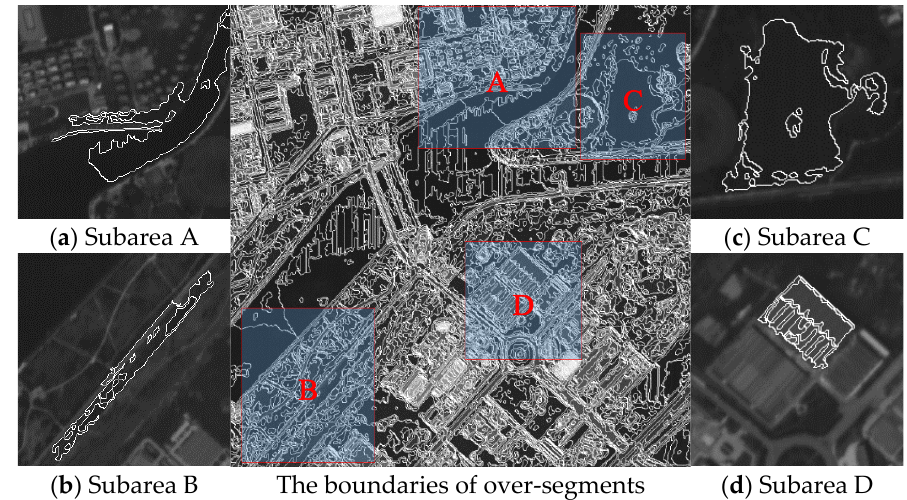
Figure 8. The boundaries of over-segments obtained by using the ddCRP_2 from the experimental image. The subfigures ( a – d ) are zoomed results from subareas A, B, C, and D, respectively.